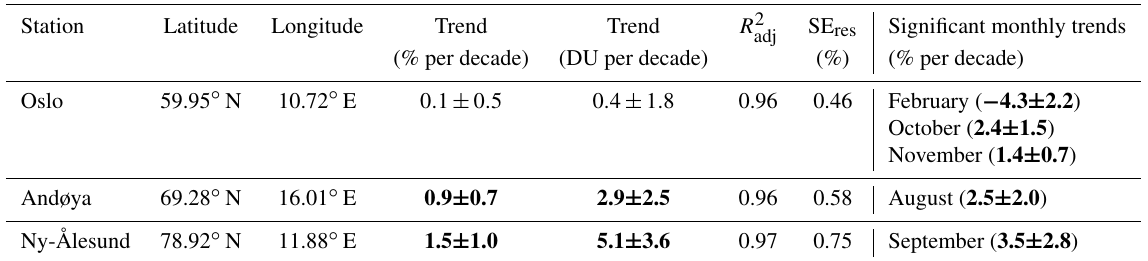
Table 3. Trend values for annual regression fits of total ozone (2000 to 2020) with R 2 Trends that are significantly different from zero at 95% confidence interval are marked in bold. The second column shows monthly trends that are significantly different from